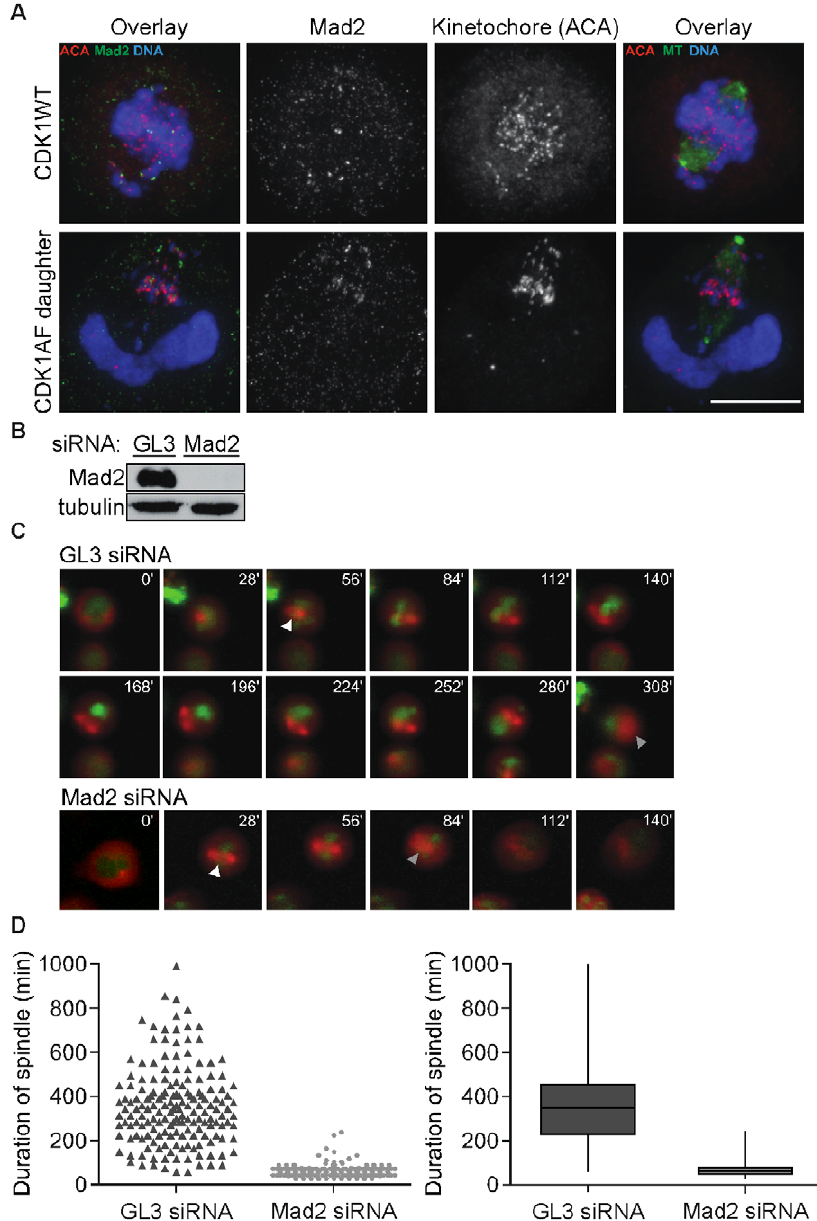
Figure 4. Mad2 stabilizes prematurely formed spindles in M-phase-like G1 cells. (A) Mad2 (green) with kinetochores (ACA; magenta) and DNA (blue) (left), or their overlay of MT (green) and DNA with kinetochores (ACA; magenta) (right) in a representative CDK1WT mitotic cell (top) and daughter produced by division of a CDK1AF-expresser (bottom). Scale bar=10 m M. (B) Mad2 (top) and tubulin (bottom) immunoblots in a cell line stably expressing histone H2B-GFP (green) and mCherry- a -tubulin (red), following co-transfection with CFP-CDK1AF and Diced siRNA pools to firefly luciferase (GL3) or human Mad2 3 9 UTR. (C) Montage of live-cell images from transfections described in (B) showing a representative GL3 d-siRNA- treated cell (top) and Mad2 d-siRNA-treated cell (bottom). White arrowheads indicate prematurely formed spindle; gray arrowheads indicate last image of apparent spindle structure. (D) Scatter plot of spindle duration times for CDK1AF/GL3-siRNA (dark gray) and CDK1AF/Mad2-siRNA (light gray) co-transfected cells (left) and box plot (right). Transfections and imaging were performed in triplicate (N=3; n GL3 and n Mad2 =167 representative cells). GL3-siRNA spindle duration: range, 60–990 min; first quartile, 225 min; median 345 min; third quartile, 450 min. Mad2-siRNA spindle duration: range, 30–240 min; first quartile, 45 min, median, 60 min; third quartile, 75 min.